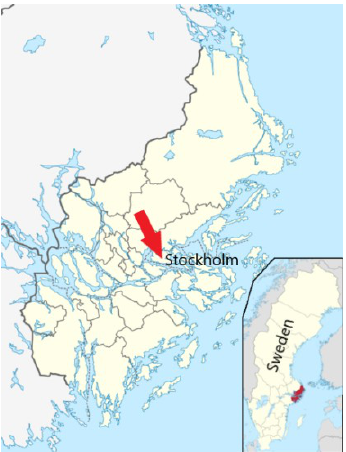
Figure 1. Sketch map of the region where the raw material was collected.